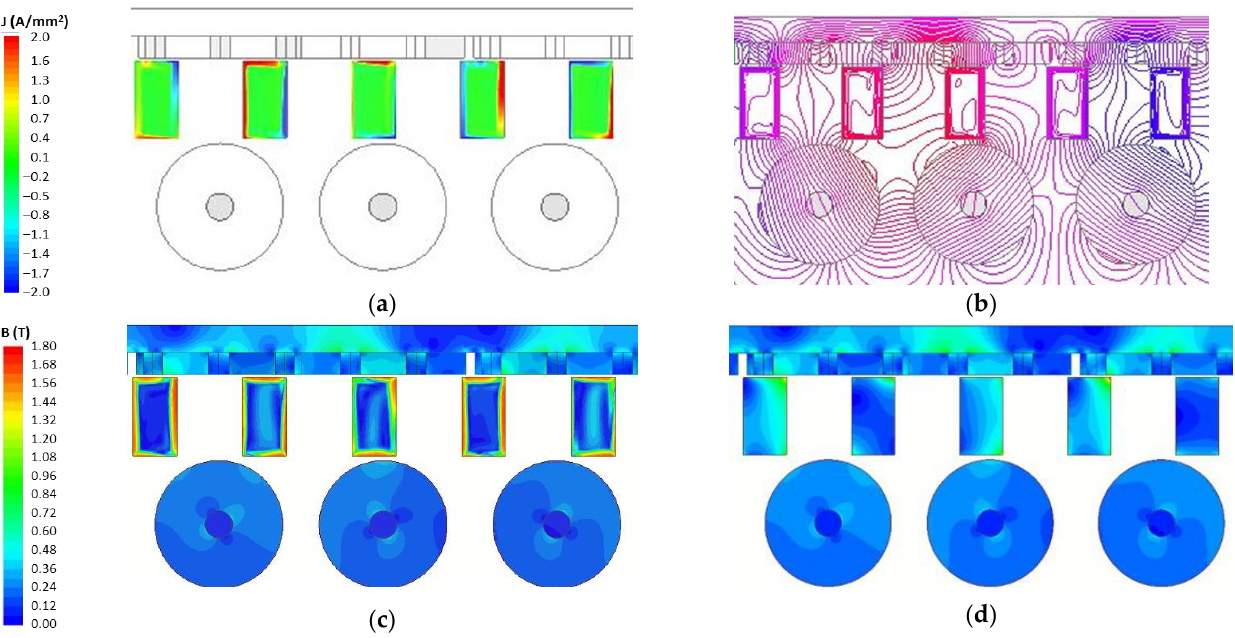
Figure 8. Maps of the electromagnetic quantities determined by the FEAs (same MR position); eddy current density ( a ), flux lines ( b ), and flux density ( c ) evaluated by the transient solver; flux density evaluated by the magnetostatic solver ( d ).